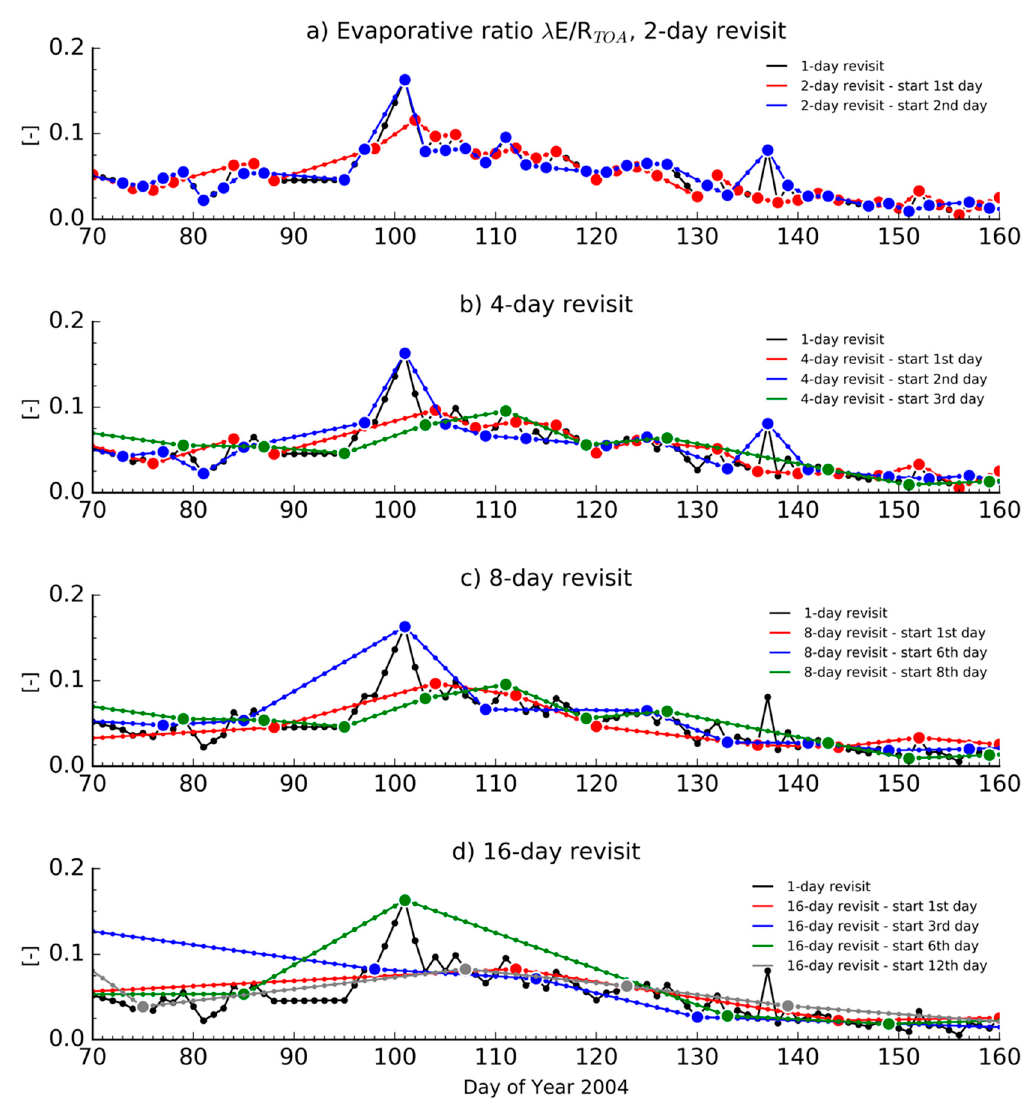
Figure 11. Evaporative ratio calculated for different revisit scenarios ( a to d : 2, 4, 8 or 16-day) using 13:00 data collected at Audubon Ranch, AZ from DOY 70 (10 March) to 160 (8 June) of 2004. For a given realization of a n-day revisit period scenario (n = 1, 2, 4, 8 or 16), the larger markers represent clear sky observations, and the smaller markers represent days with no satellite observations (due to return period or clouds) associated with evaporative ratios estimated from two consecutive clear sky observations using linear interpolation. For a given n-day revisit scenario, the different realizations show the impact of precipitation events that occurred in April 2004.